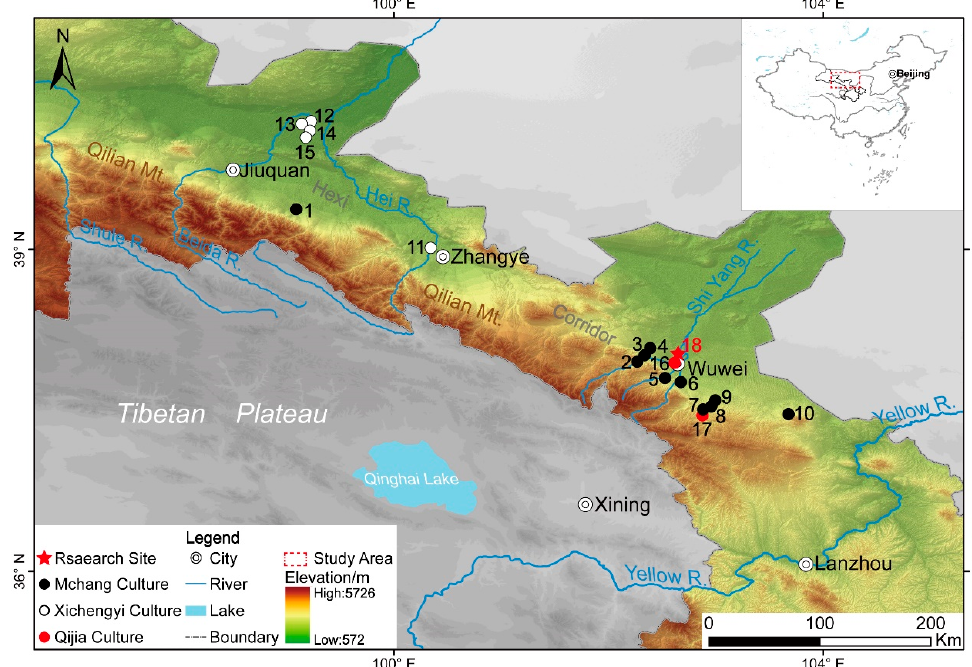
Figure 1. Location of Machang culture, Xichengyi culture, and Qijia culture sites in the Hexi Corridor, Northwest China. Machang culture sites (4300–4000 BP): 1. Xihetan; 2. Qipanshan; 3. Xinzhai; 4. Guojiashan; 5. Maolinshan; 6. Mozuizi; 7. Xitai; 8. Shuikou; 9. Duojialiang; 10. Guandi. Xichengyi culture sites (4000–3600 BP): 11. Xichengyi; 12. Huoshiliang; 13. Ganggangwa; 14. Yigediwonan; 15. Yigediwonan2. Qijia culture sites (4000–3600 BP): 16. Huangniangniangtai; 17. Lijiageleng; 18. Haizang.